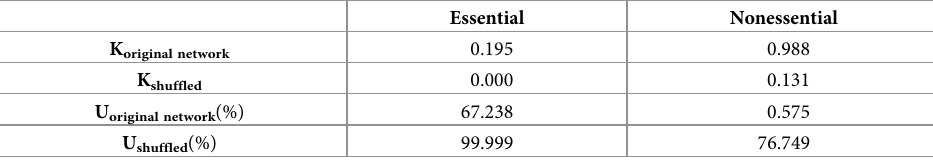
Table 4. Walk-balance index for all cycles (K), percentage of the lack of balance (U).